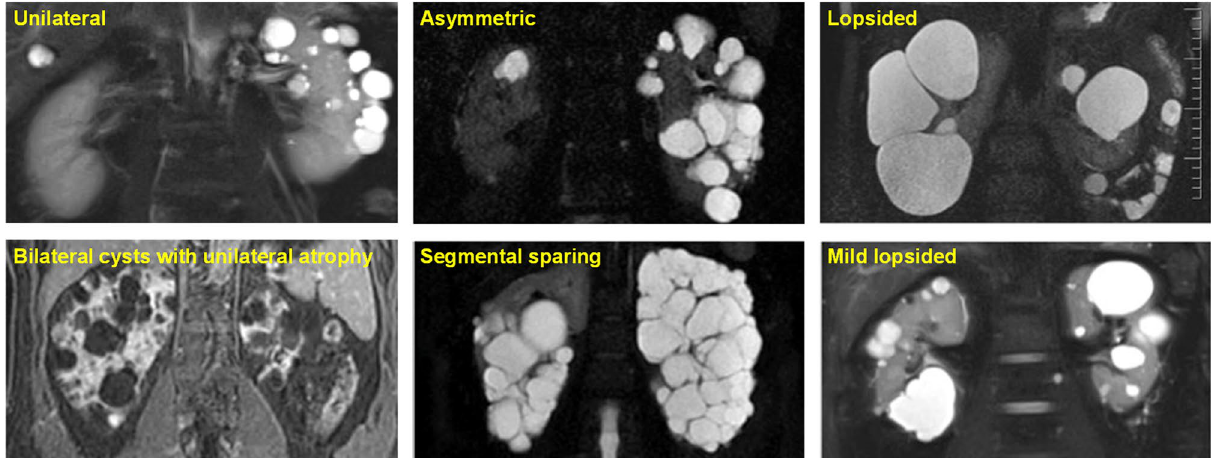
Figure 1. Illustrations of atypical imaging patterns. These include: unilateral (diffuse cystic involvement of only one kidney); asymmetric (diffuse cystic involvement of one kidney with mild involvement of the contralateral kidney); lopsided (bilateral distribution of cysts with mild replacement of kidney tissue with atypical cysts where 2–5 cysts account for ≥ 50% of total kidney volume); bilateral presentation with acquired unilateral atrophy (diffuse cystic involvement of one kidney with contralateral acquired atrophy); segmental sparing (bilateral and diffuse distribution with sparing of one kidney pole); mild lopsided (same definition as lopsided, but with the larger cysts accounting for 15–49% of total kidney